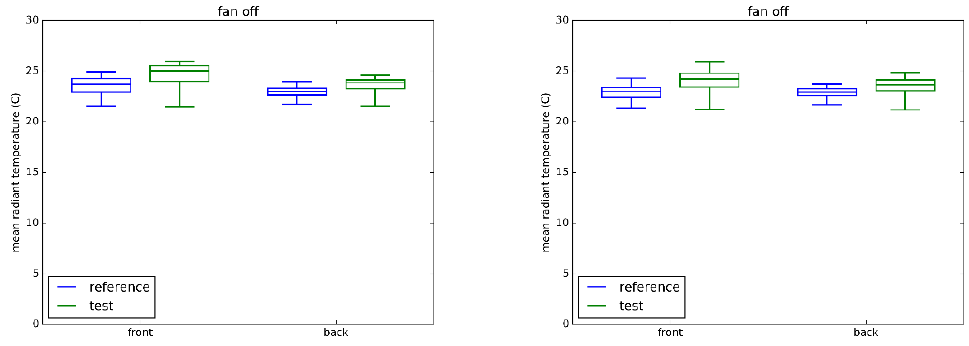
Figure 16. Mean radiant temperature (MRT) in Core-S ( left ) and Core-W ( right ) configurations.